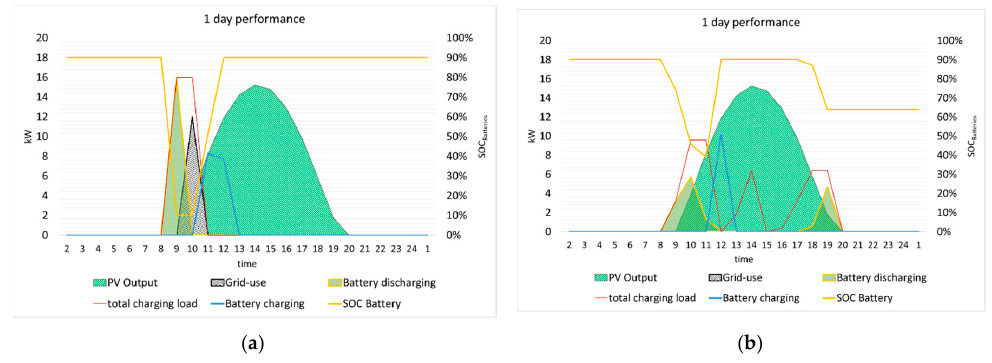
Figure 14. One-day energy performance: ( a ) according to non-stochastic charging profiles and ( b ) according to stochastic charging profiles.